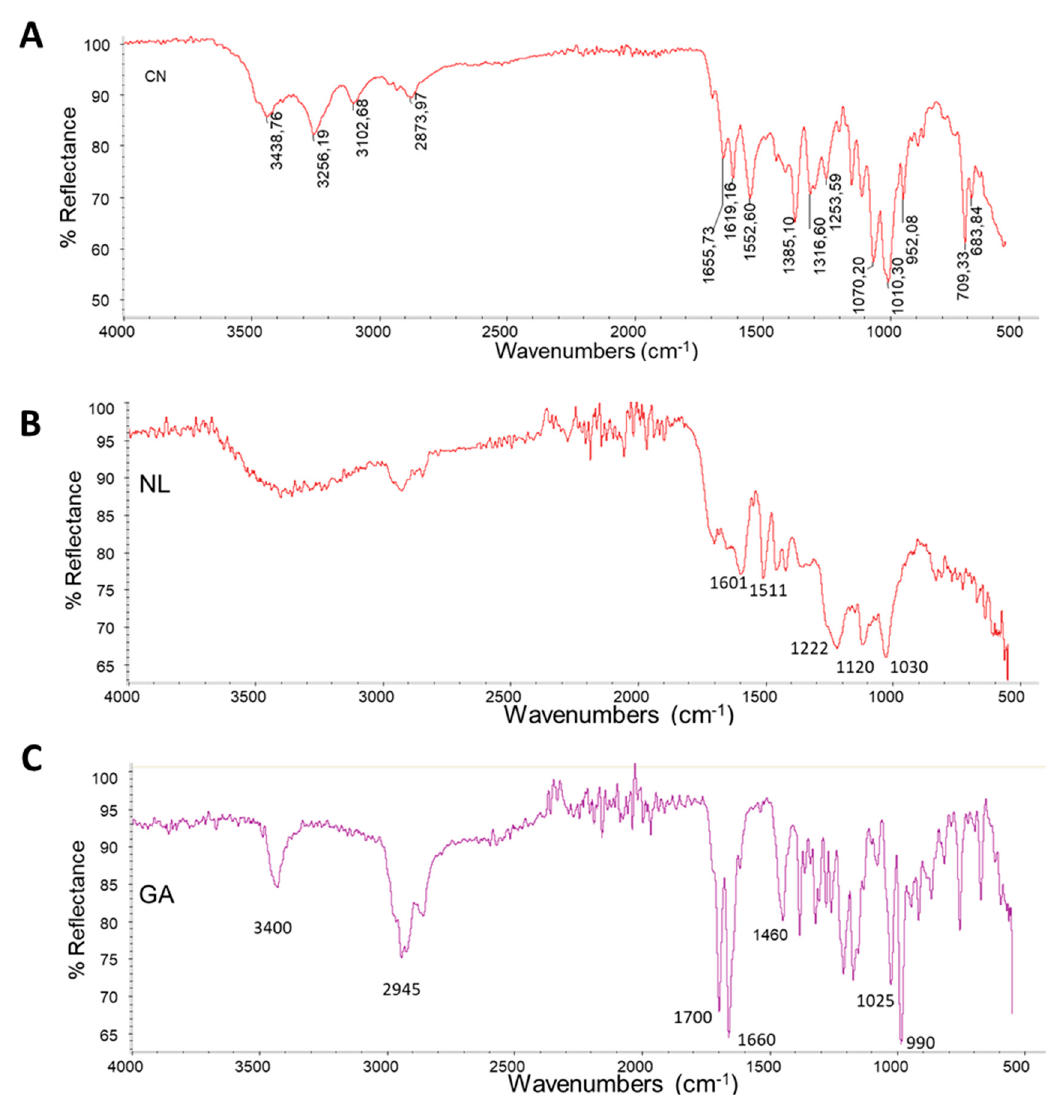
Figure 3. Infrared ATR spectra of ( A ): CN; ( B ) NL; ( C ) GA.